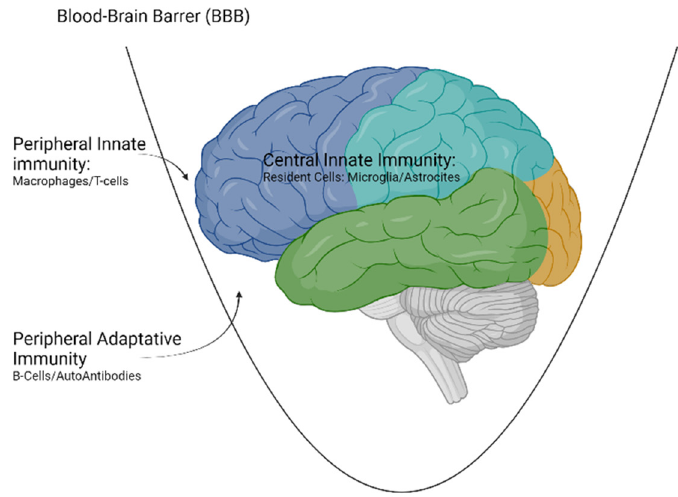
Figure 1. Types of immunity acting at the level of the CNS. Created with www.Biorender.com (last access on 15 March 2022).